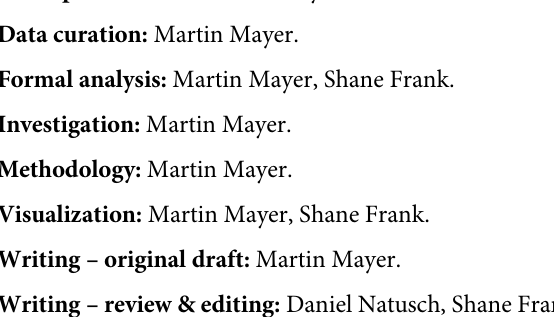
S1 Fig. Illustration of how we calculated the starting distance: The starting distance was defined as the maximum straight-line distance between the boat and the bird location not intersected by any elevation or vegetation. Source of digital elevation model: https:// kartkatalog.geonorge.no. S1 Table. All raw data of our water bird